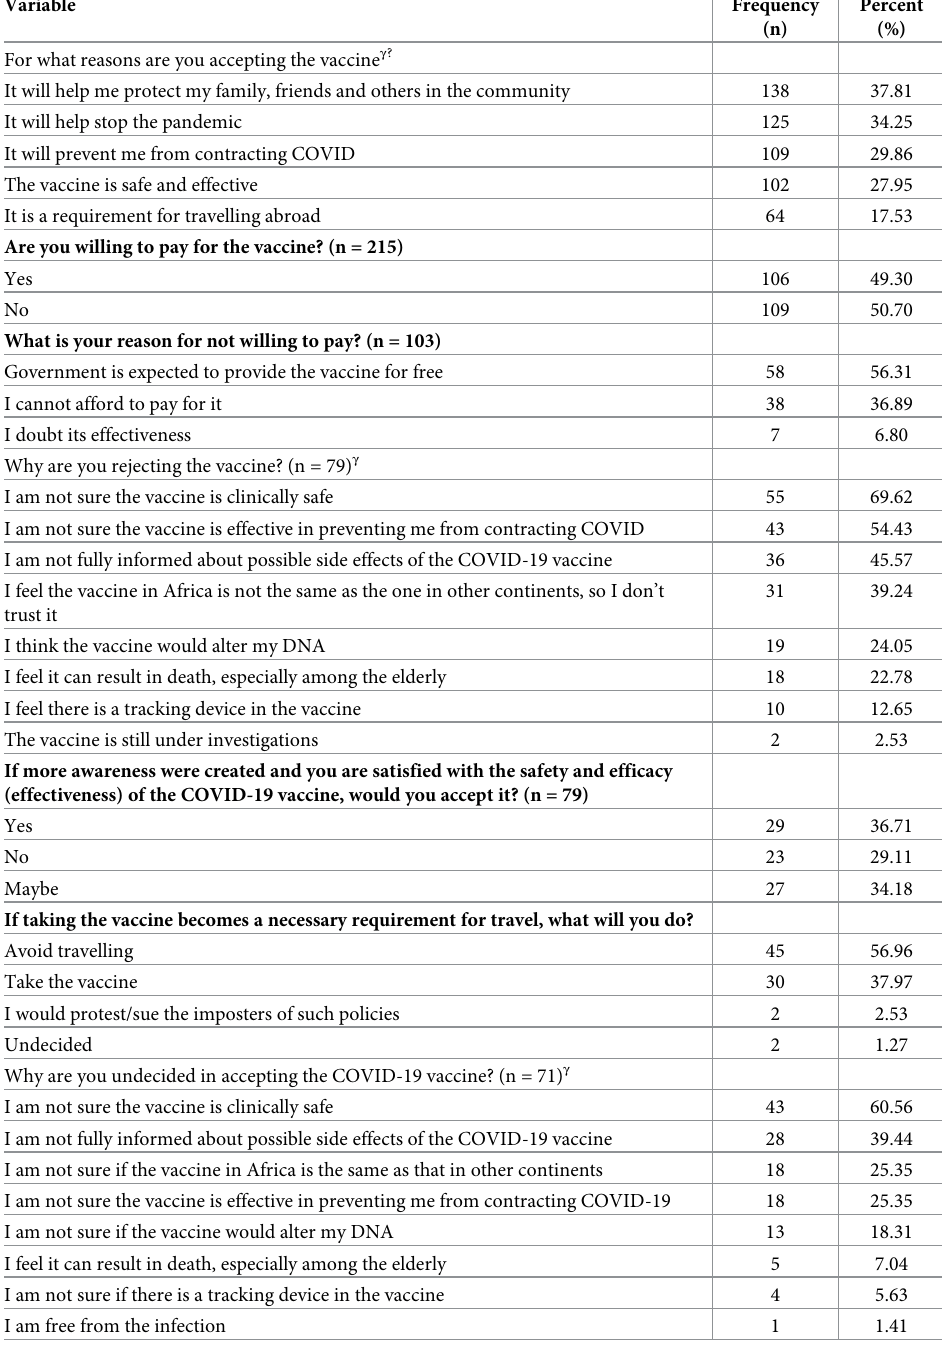
Table 5. Public willingness and readiness to accept COVID-19 vaccines (n =